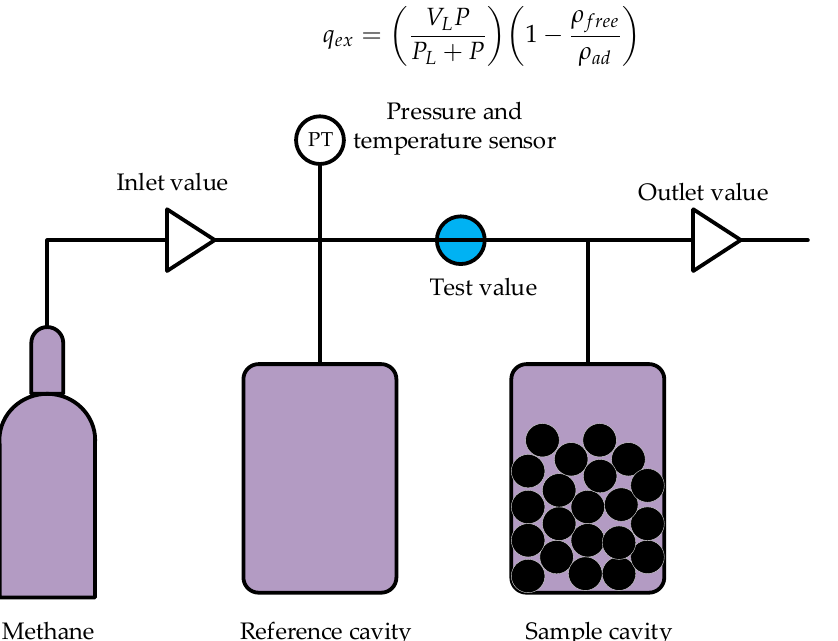
Figure 4. Isothermal methane adsorption measurement.